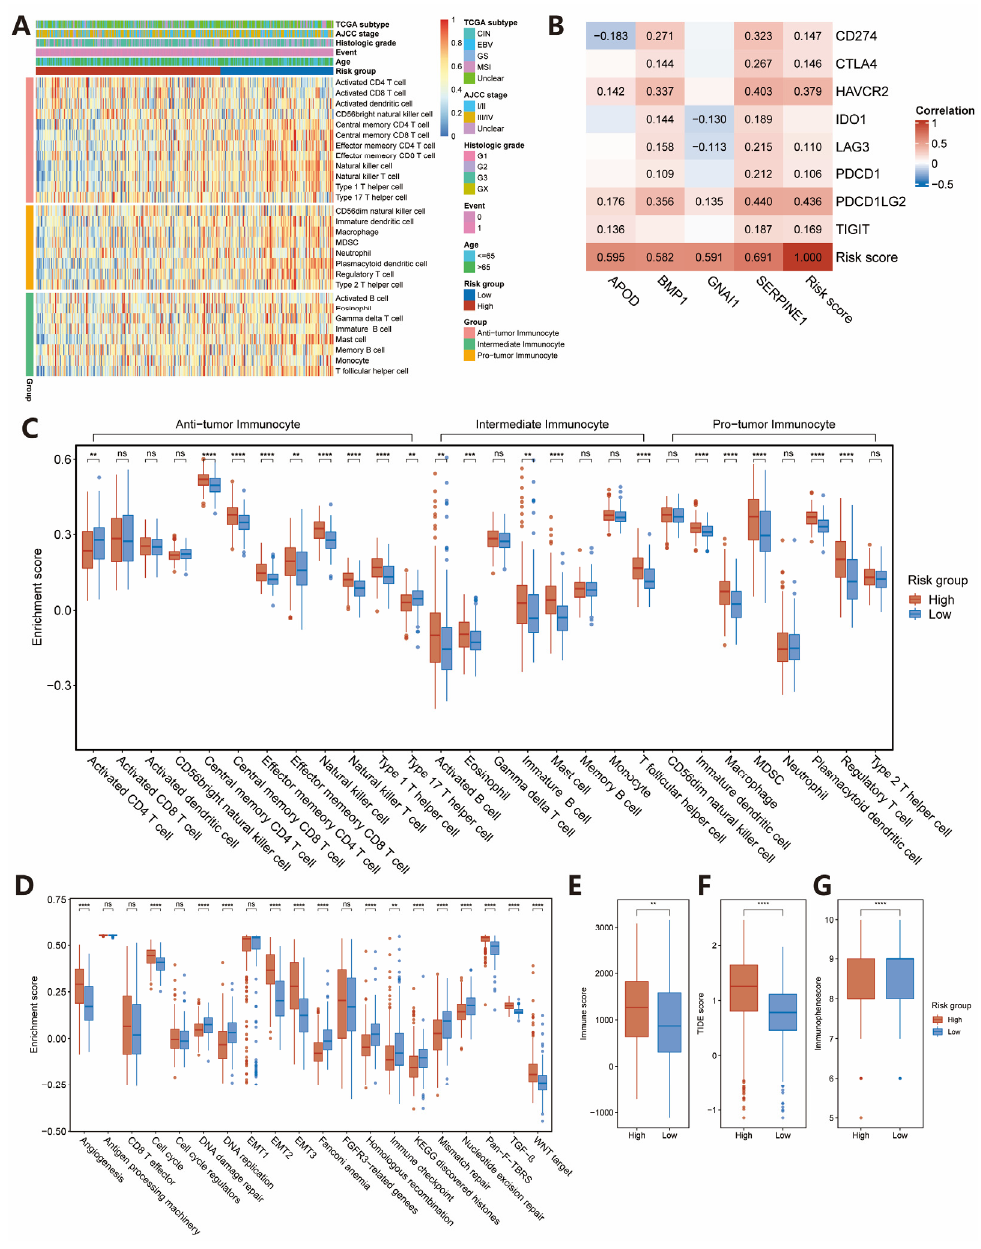
Figure 3. Transcriptome traits and clinical characteristics of TME phenotypes in the TCGA-STAD cohort. ( A ) ssGSEA identified the relative infiltration of 28 tumor-infiltrating immune cell types with different risk groups in the TCGA-STAD cohort. ( B ) Correlation matrix of risk score, four IRGs and seven immune-checkpoint-relevant genes (Spearman test, p < 0.05). ( C , D ) The relationship between risk score and 28 tumor-infiltrating immune cell types or pathways using ssGSEA. ( E – G ) Comparison of Immune, TIDE scores, and IPS between high- and low-risk groups in TCGA-STAD cohort. Wilcoxon test, ** p < 0.01; *** p < 0.001; **** p < 0.0001; ns, not statistically